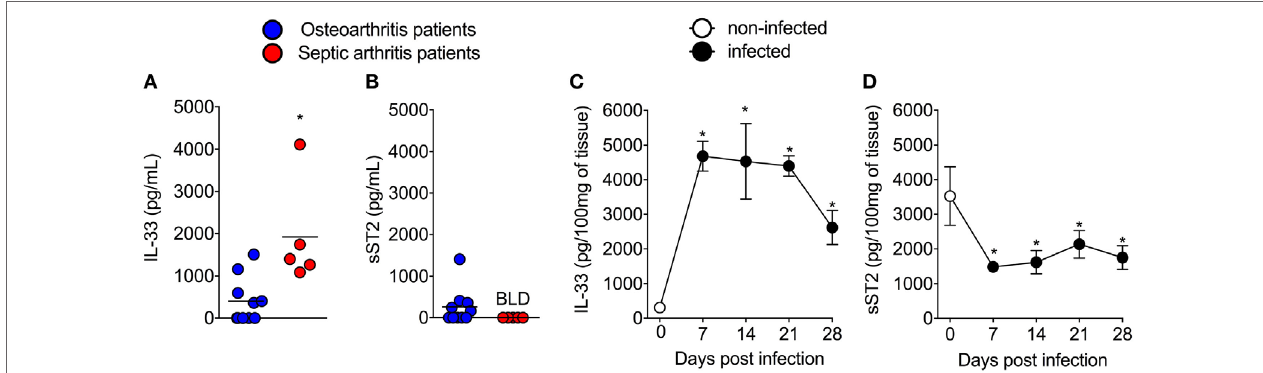
FigUre 1 | Interleukin-33 (IL-33) and sST2 levels in synovial fluid samples of septic arthritis and osteoarthritis patients, and similar profile in mouse septic arthritis. (a,B) Synovial fluid samples from patients with septic arthritis and osteoarthritis were collected and processed to determine the levels of IL-33 and sST2 by ELISA. (c,D) Staphylococcus aureus or saline (day 0) was injected in in the femur-tibial joint of wild-type and knee joints samples were collected and processed to determine the levels of IL-33 and sST2 at indicated points (7–28 days) post S. aureus injection by ELISA. For clinical samples analysis: n = 5 for septic arthritis and n = 10 for osteoarthritis patients. * P < 0.05 vs osteoarthritic patients group (a,B) . Kruskal–Wallis test followed by Dunn’s test. For mice samples analysis: n = 6 per group, representative of two independent experiments. * P < 0.05 vs day 0 of infection (c,D) . Two-tailed unpaired Student’s t